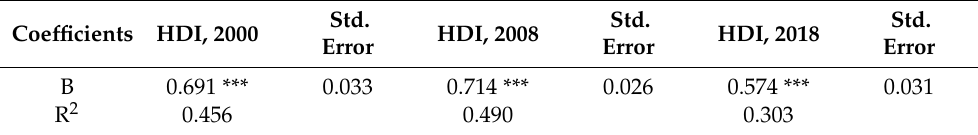
Table 3. Binary regression results between residential energy use per capita and